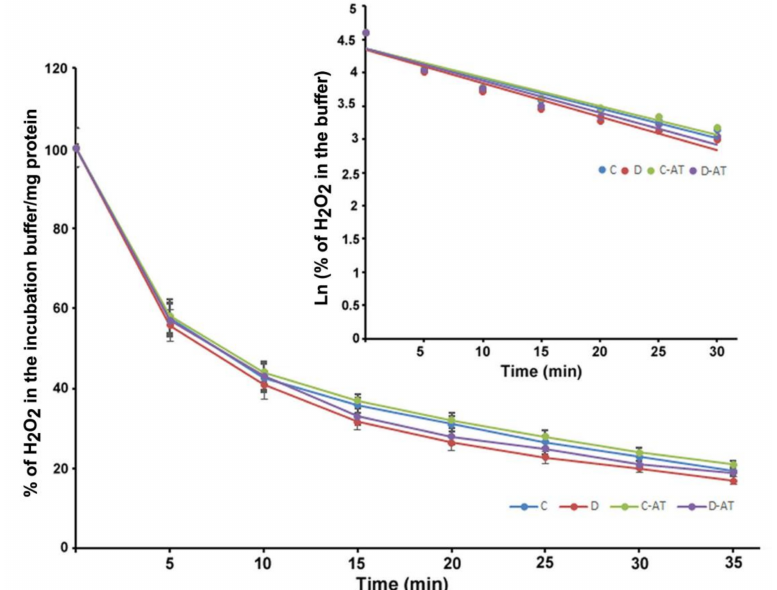
Figure 3. Clearance of H 2 O 2 by 10 weeks excised control and diabetic retina under euglycemic and hyperglycemic incubation conditions. Control retinas were incubated in the buffer containing 5 mM glucose ± 3-AT and diabetic retinas with the buffer containing 20 mM glucose ± 3-AT. The retinas were pre-incubated for 30 min in the incubation buffer with or without 3-AT. Clearance reactions by the retinas started with the addition of 5 µ M H 2 O 2 . Insert: semi-logarithmic representation of the data obtained during the 30 min period. The half-lives are approximately 10 and 9 min, in the control and diabetic retina, respectively. No significant change in the H 2 O 2 disposal rate was observed in the case of 3-AT treatments in both control and diabetic retinas. Values are means ± SEM for 5 determinations (n = 5 for